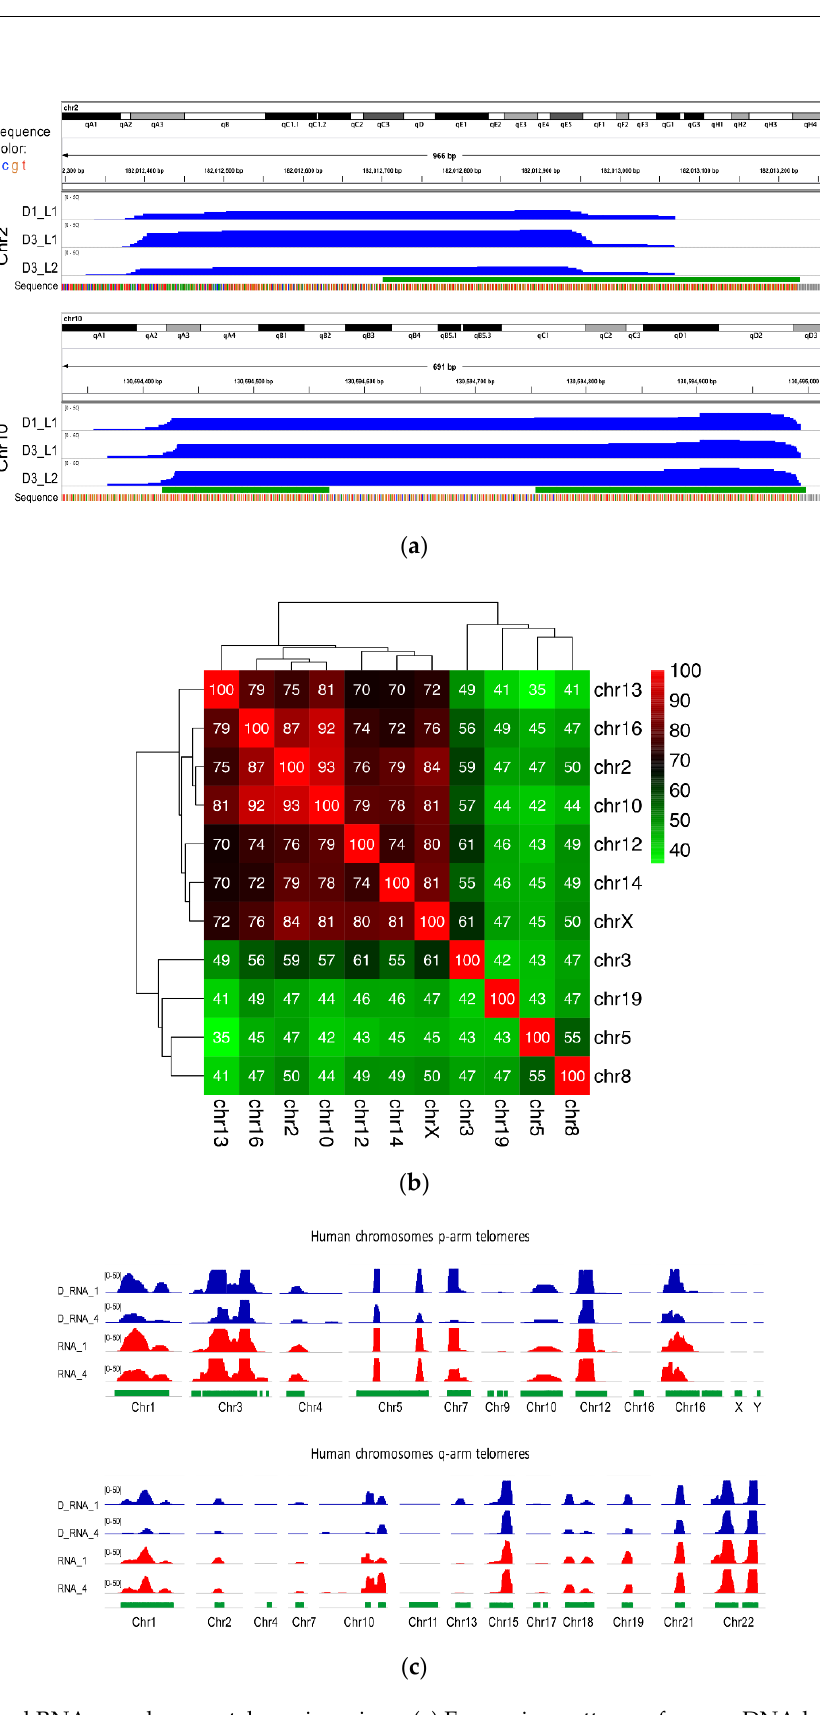
Figure 4. DNA-bound RNA samples over telomeric regions. ( a ) Expression patterns of mouse DNA-bound RNA samples over q-arm telomeric regions of chromosomes 2 and 10. The upper track of each panel shows the whole chromosome,